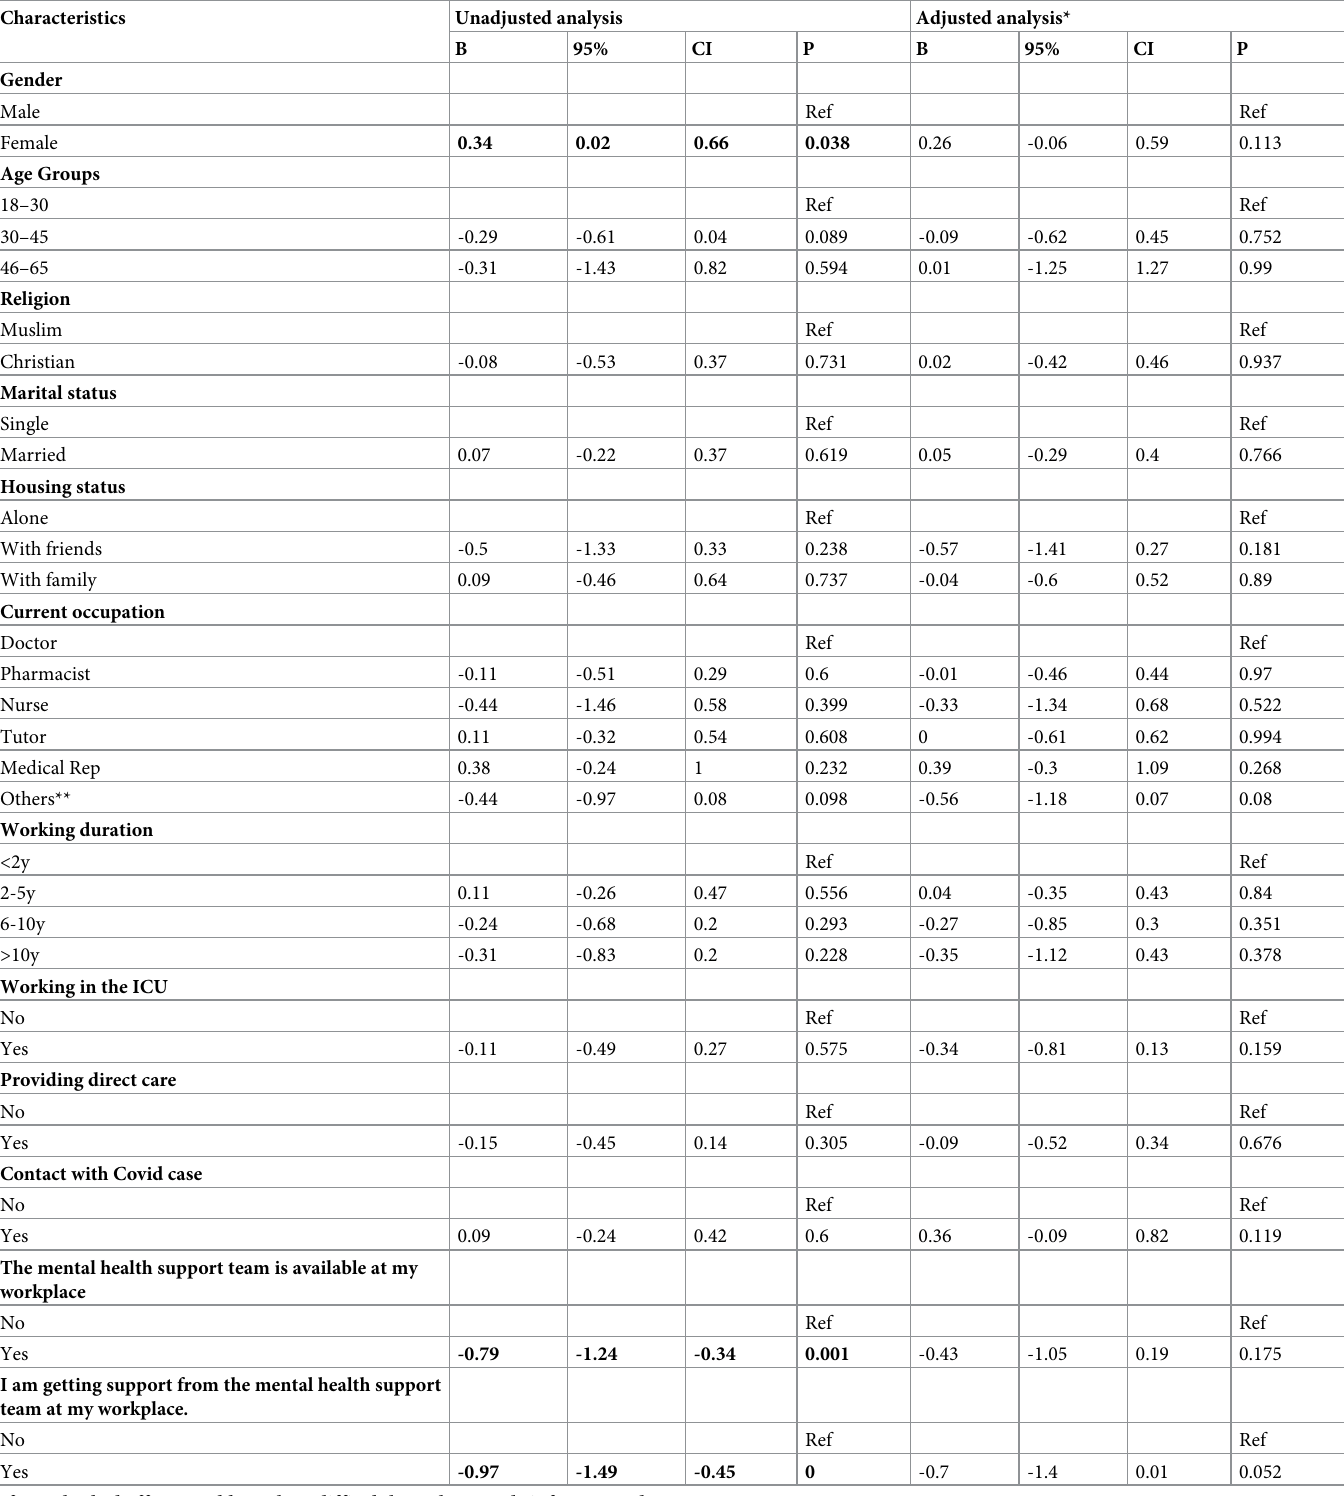
Table 4. General linear model: Predictors of risk perception towards COVID-19.